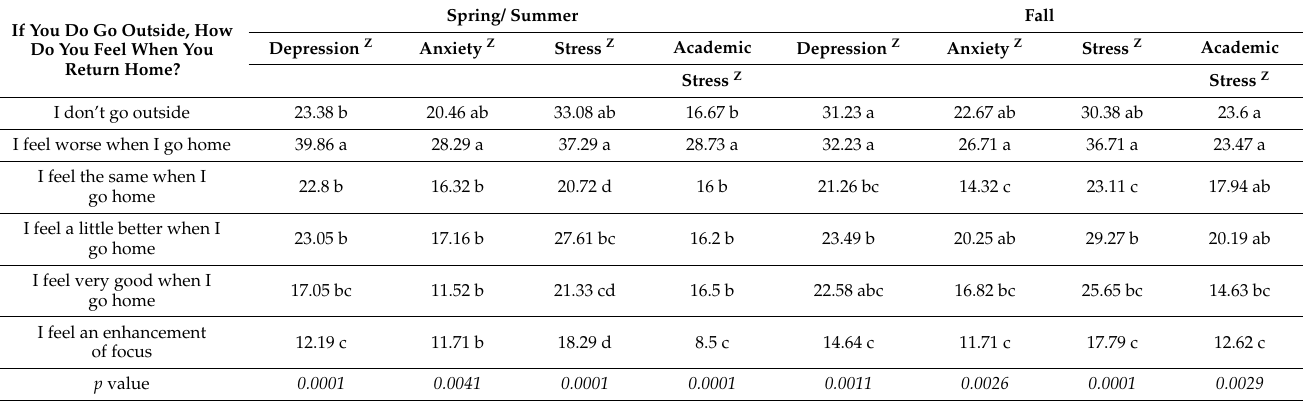
Table 4. Influence of going outside on depression, anxiety, stress, and academic stress by